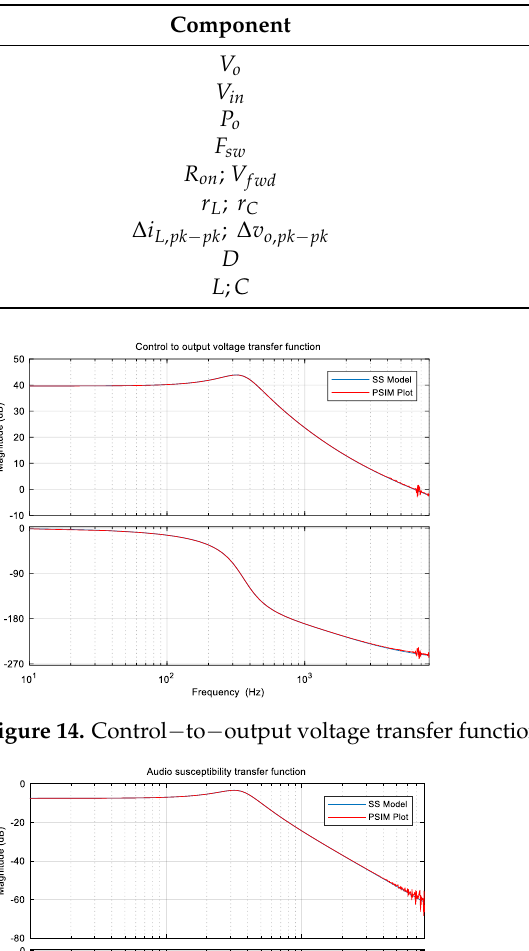
Table 5. Buck-boost converter parameters.